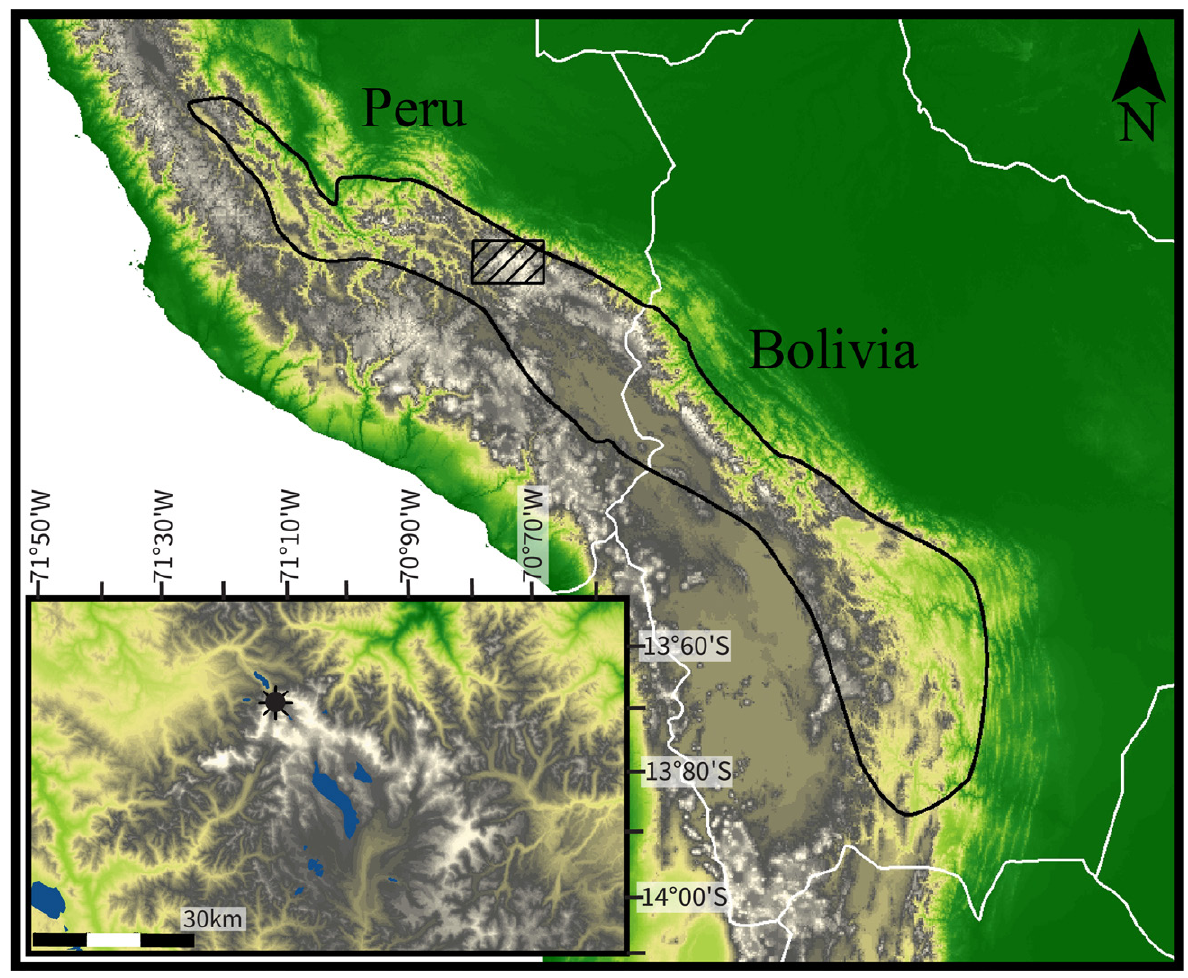
Figure 1. Distribution map of Gastrotheca marsupiata . The white lines represent national borders, and the black outline represents the species distribution (IUCN 2020). The small, hatched box marks the location of the inset map, and the black star on the inset map repre- sents the location of our new